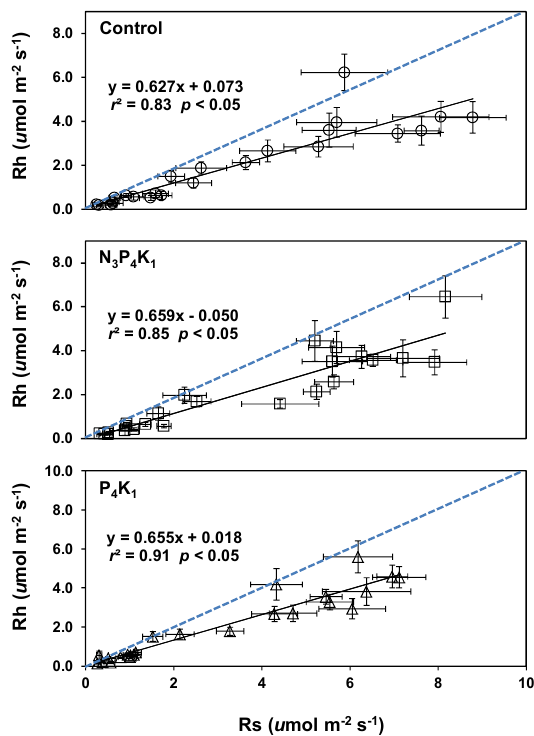
Figure 5. Relationships between Rs and Rh rates for fertilizer (N 3 P 4 K 1 : squares; P 4 K 1 : triangles) and control (circles) treatments in red pine stands. Vertical bars represent standard error ( n = 12). Dashed line represents a 1:1 relationship (Intercept = 0; slope = 1) between Rs and Rh rates in red pine stands.